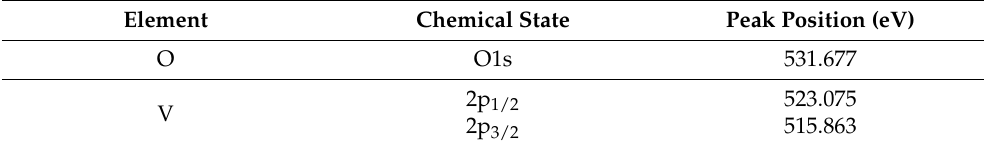
Table 1. XPS spectral parameters of the deconvoluted peaks for sesquioxide vanadium.